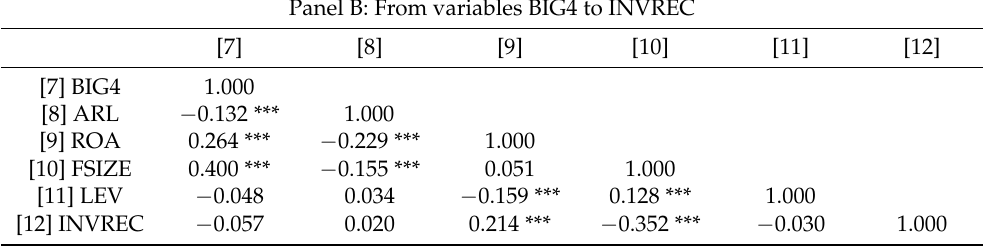
Panel B: From variables BIG4 to